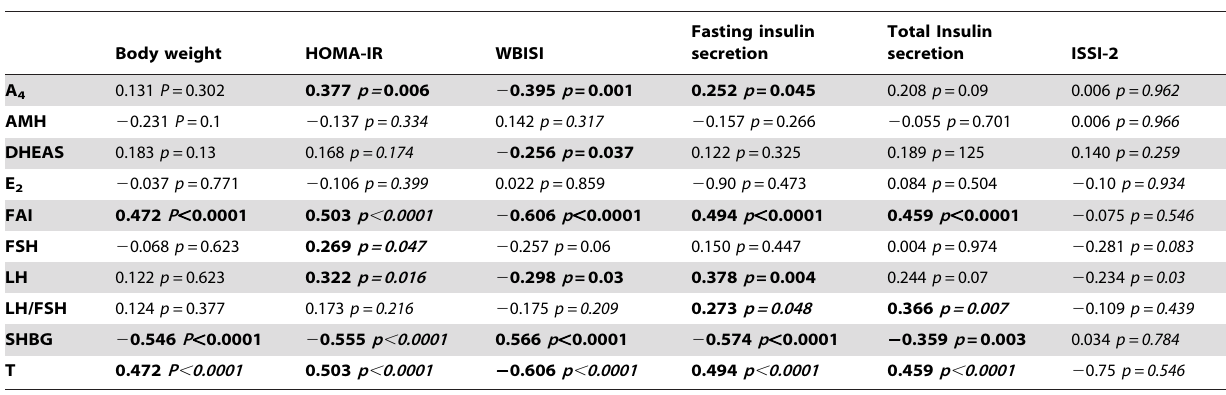
Table 2. Coefficients of correlation in patients with PCOS.